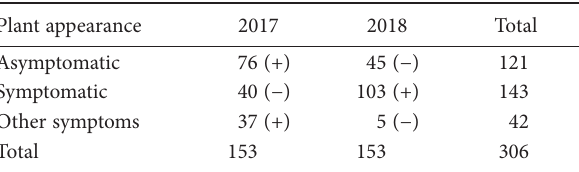
Table 2. Occurrence of grapevines without (asymptomatic) or with GLMD symptoms (symptomatic), or with symptoms of other virus diseases (other symptoms) in 2017 and 2018. Results of Pearson’s standardized residuals, indicating statistical differences between observed and expected values, are indicated in parentheses.